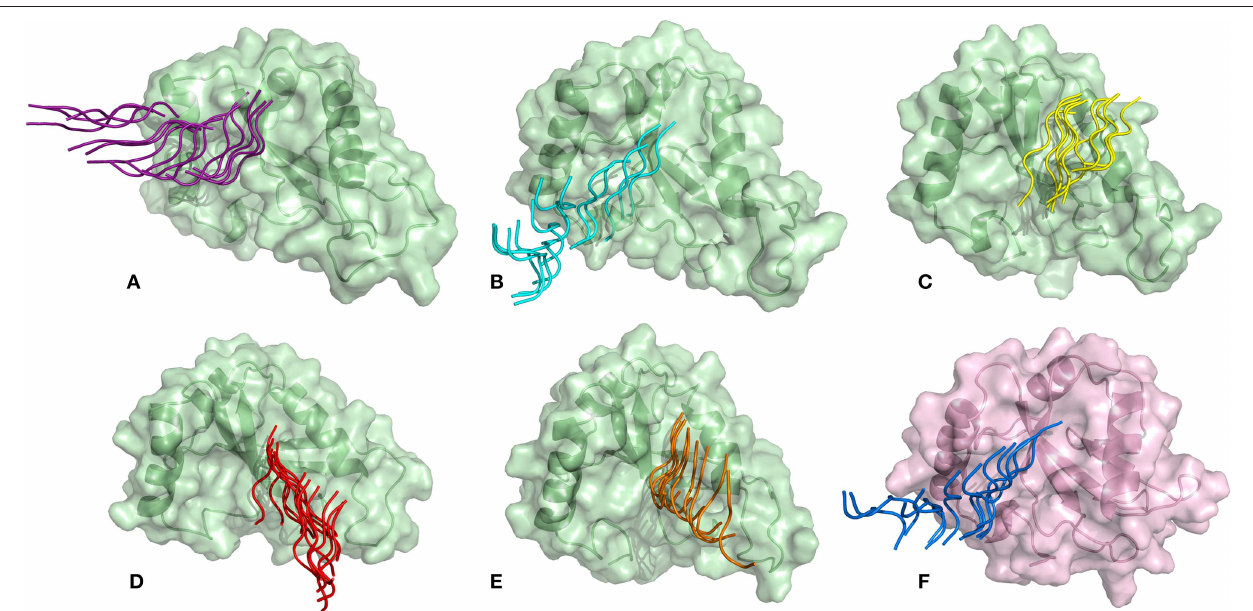
FIGURE 7 | Dissociation of AIM/LIR peptides from the binding site of their respective Atg8/LC3 autophagy proteins: (A) Pf Sec62 QSYIDI (magenta), (B) Pf Sec62 SMYKSI (cyan), (C) Pf Sec62 ENYDCL (yellow), (D) Pf Sec62 TSFEEL (red), and (E) Pf Atg3 NDWLLP (orange) LIR motifs bound to Pf Atg8 (green), and (F) Hs Sec62 NDFEMI (blue) bound to HsLC3 (pink).